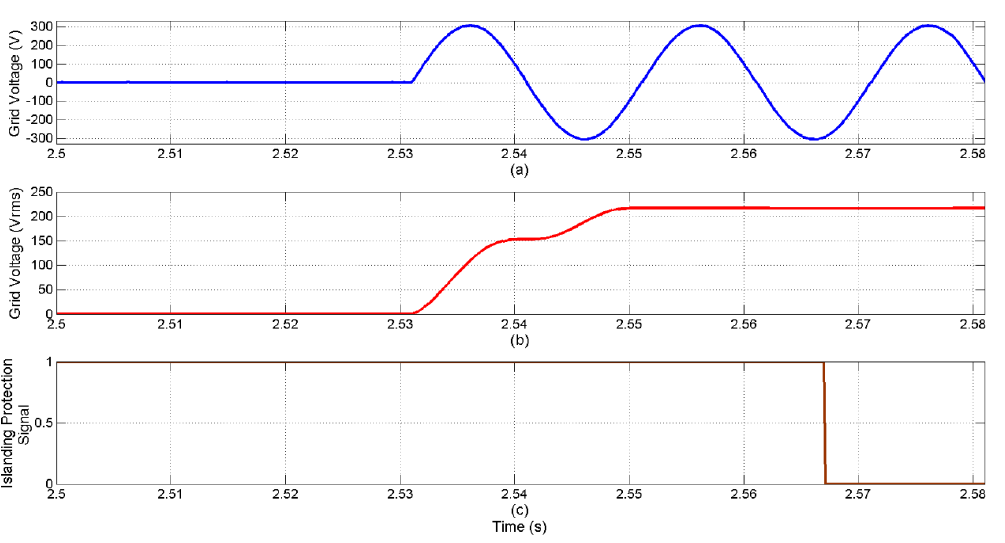
Figure 15. The change of the battery voltage when the power grid fails. ( a ) Battery voltage [V] ( b ) Islanding protection signal.